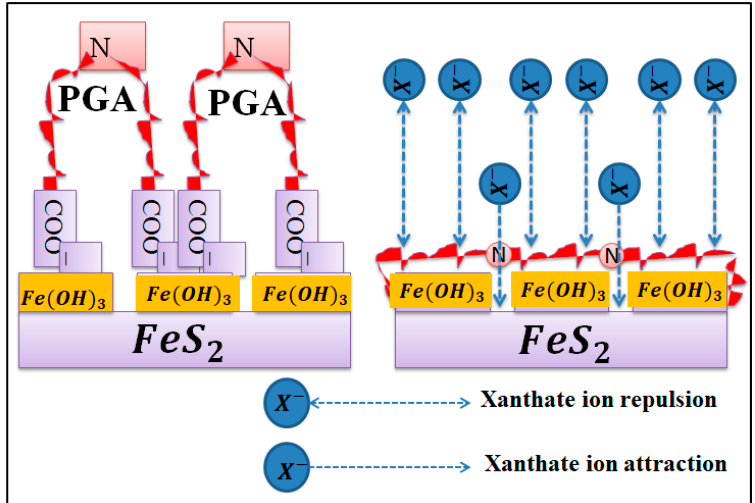
Figure 11. Schematic illustration of the adsorption model and depression mechanism of PGA on Figure 11. pyrrhotite.